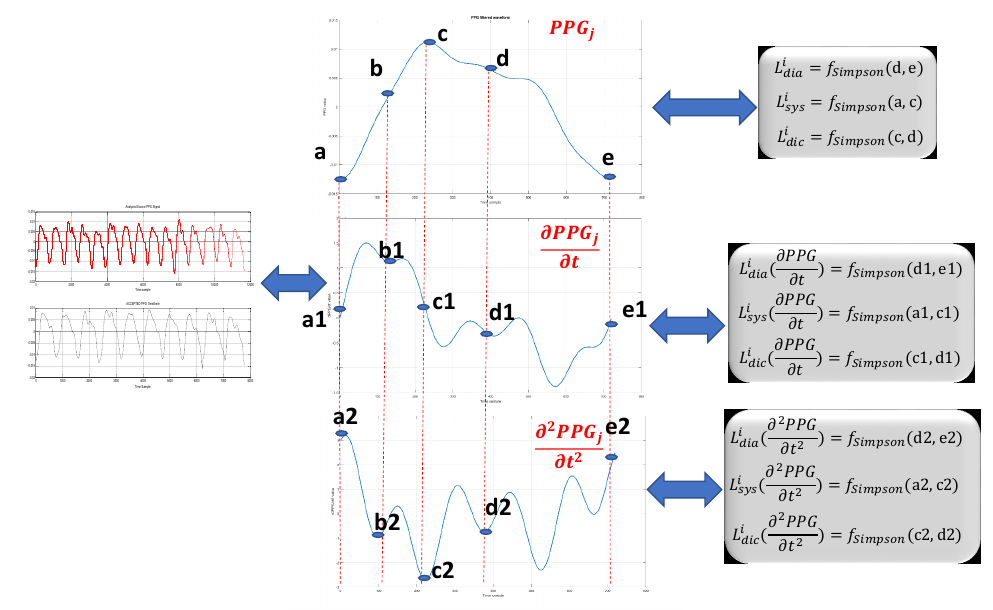
Figure 5. Detailed description of the key-points of PPG, first and second